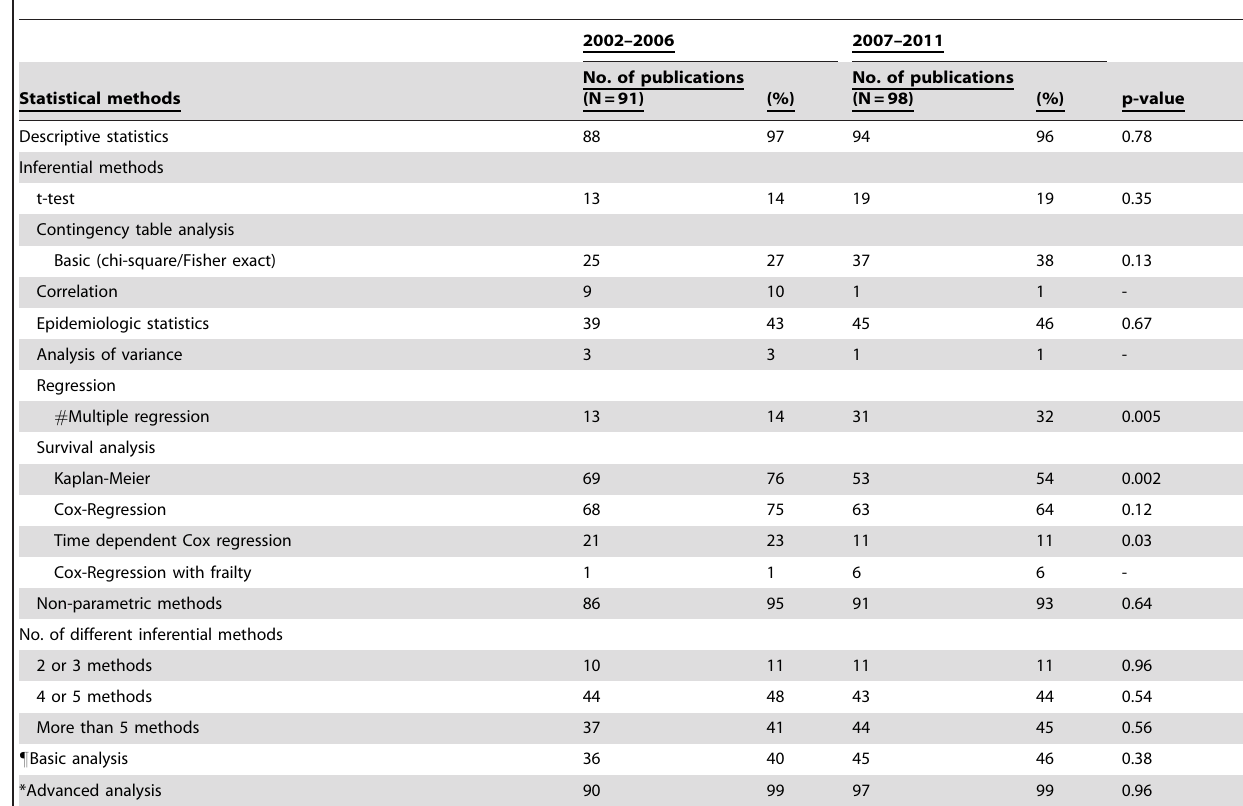
Table 3. Summary of statistical